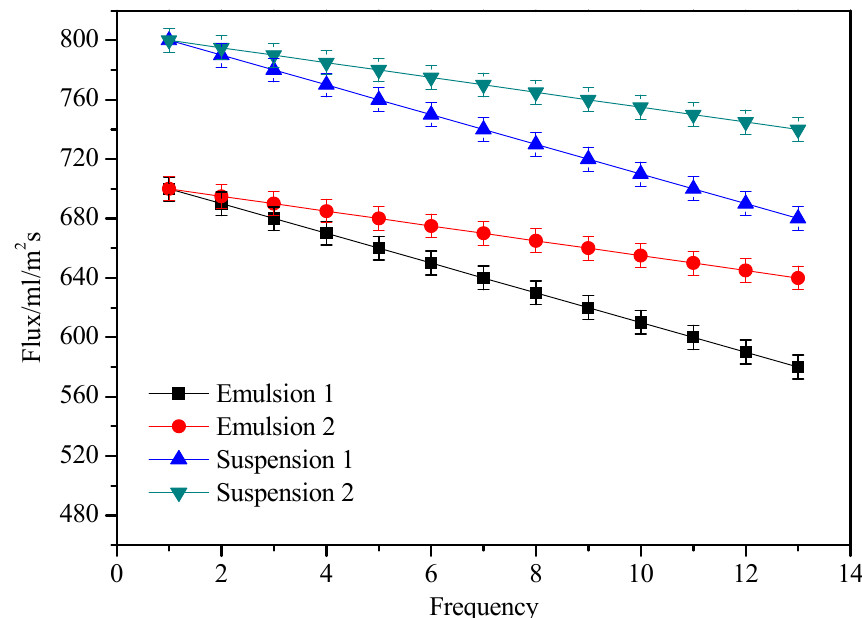
Figure 11. E ff ect of the number of membrane filtration on